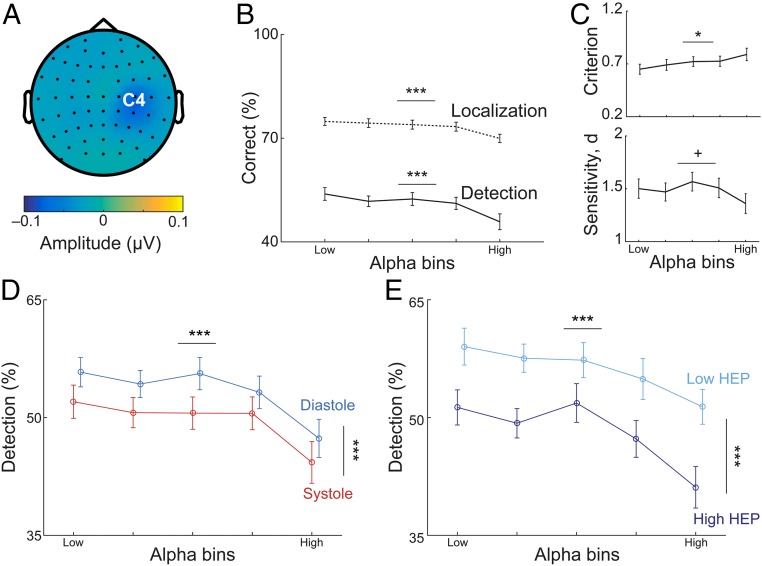
Prestimulus sensorimotor alpha amplitude affects somatosensory perception but does not mediate heartbeat-related perceptual effects. (A) Topography of prestimulus alpha (8 to 13 Hz) difference between hits and misses in the time window of 300 to 0 ms before stimulus onset. (B) Trials were sorted into five equal bins of increasing mean sensorimotor alpha amplitudes in the prestimulus time window of 300 to 0 ms over contralateral somatosensory cortex (C4 electrode). Correct detection and localization rates are given for each alpha bin. Both detection and localization decreased as alpha amplitude levels increased (P = 3⋅10−7 and P = 4⋅10−5). (C) The decrease in detection rates with increasing alpha amplitude levels was associated with a significant increase in criterion, that is, a higher bias to miss the target (P = 0.006; Top) and a trend toward lower sensitivity (P = 0.07; Bottom). (D) For each alpha bin, detection rates are given separately for systole and diastole. Cardiac phase and alpha levels affected detection rate in an additive fashion (within-subject ANOVA test, F1,36 = 15.82, P = 3⋅10−4 and F2.93,105.30 = 12.05, P = 1⋅10−6). (E) For each alpha bin, detection rates are given separately for the trials with highest and lowest HEP, respectively. Prestimulus HEP amplitudes across the time window 296 to 400 ms after the R-peak were categorized in three equal bins for each participant, and detection rates were determined separately for the lowest and highest HEP conditions within each alpha bin. Both prestimulus factors, that is, HEP amplitudes and alpha amplitudes, influenced detection rates independently (within-subject ANOVA F1,36 = 38.71, P = 4⋅10−7 and F4,144 = 10.37, P = 2⋅10−7). Error bars represent SEMs. +P < 0.08, *P < 0.05, ***P < 0.0005.